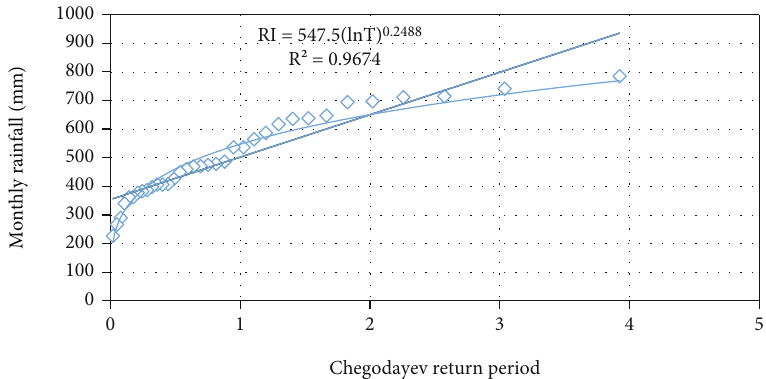
Figure 8: Chegodayev ’ s probability plotting